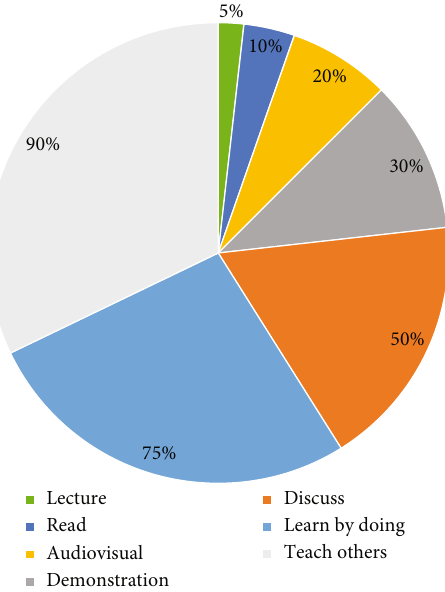
Figure 3: Pyramid of teaching method e ff